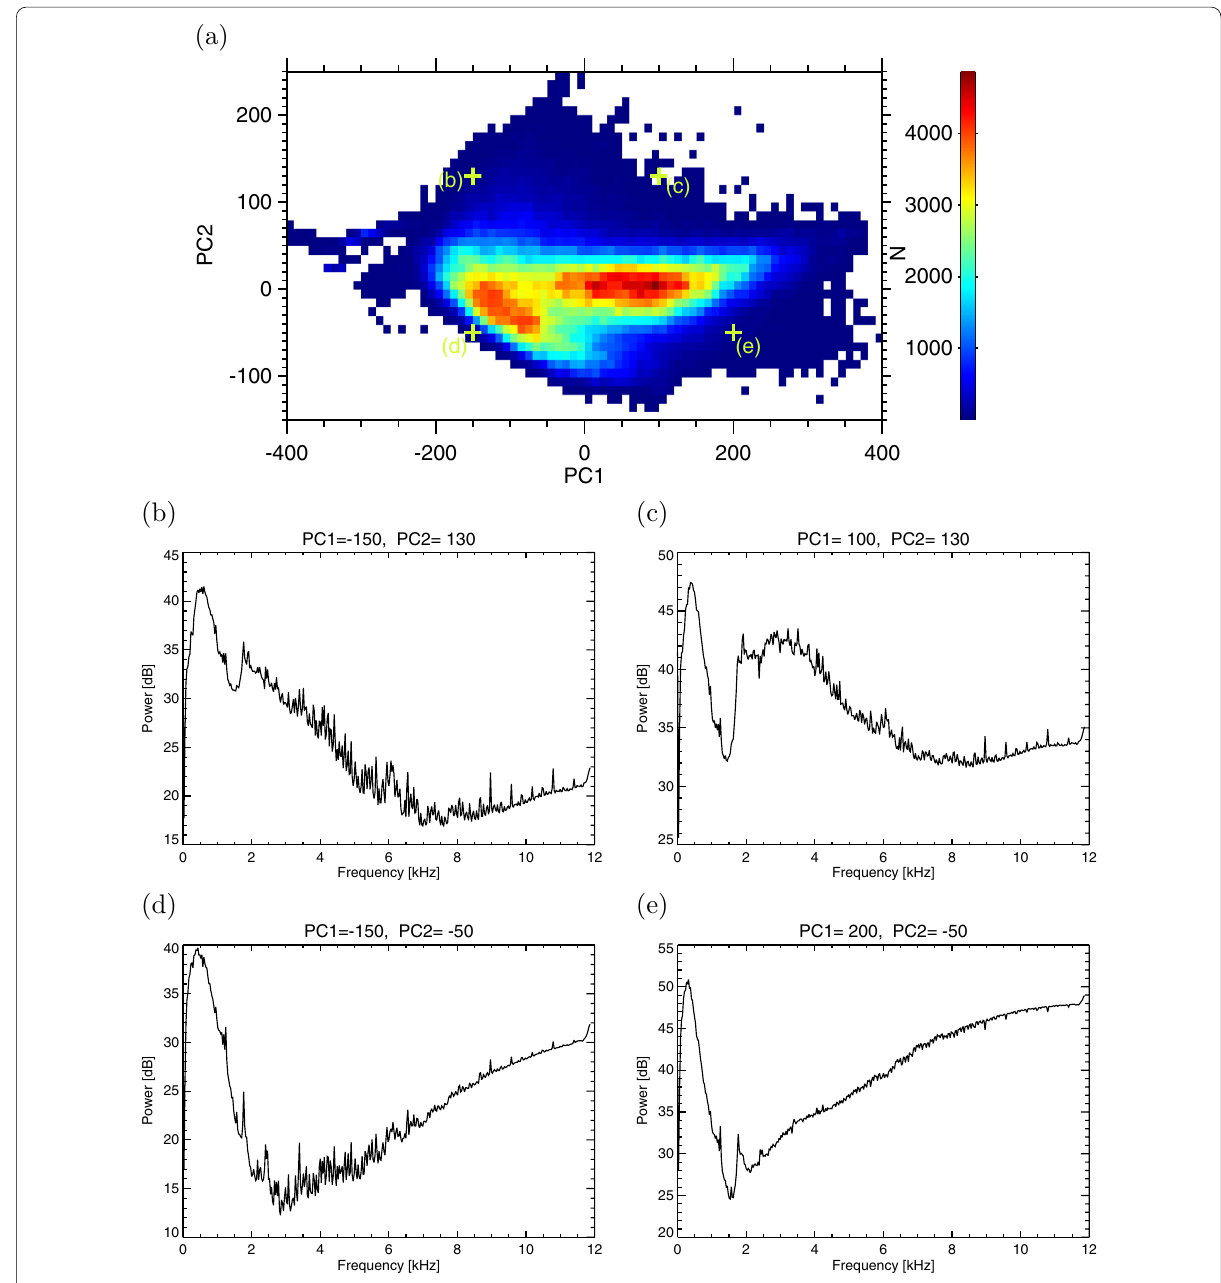
Fig. 8 a Scatter plot of individual principal component coefficients PC1 and PC2 obtained for frequency spectra. b – e Frequency spectra obtained using the first two principal component coefficients. Their coordinates are plotted in panel (a) by green crosses and correspond to b [ [100, 130], d [ 150, 50], e [200, − − −